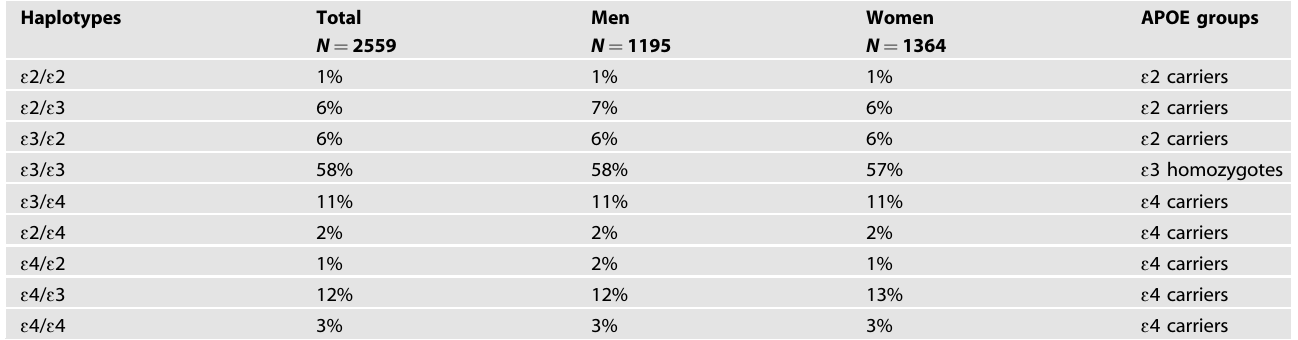
Table 2. APOE haplotypes for the total population and for men and women separately.